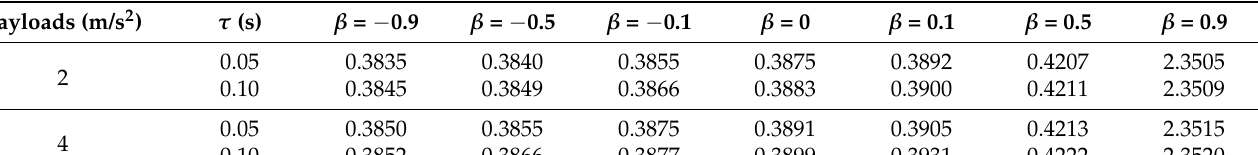
Table 17. Root mean squared value of the control signal u 4 in the first 30 s under different payloads, different input time delays and different fractional orders in the proposed controller.